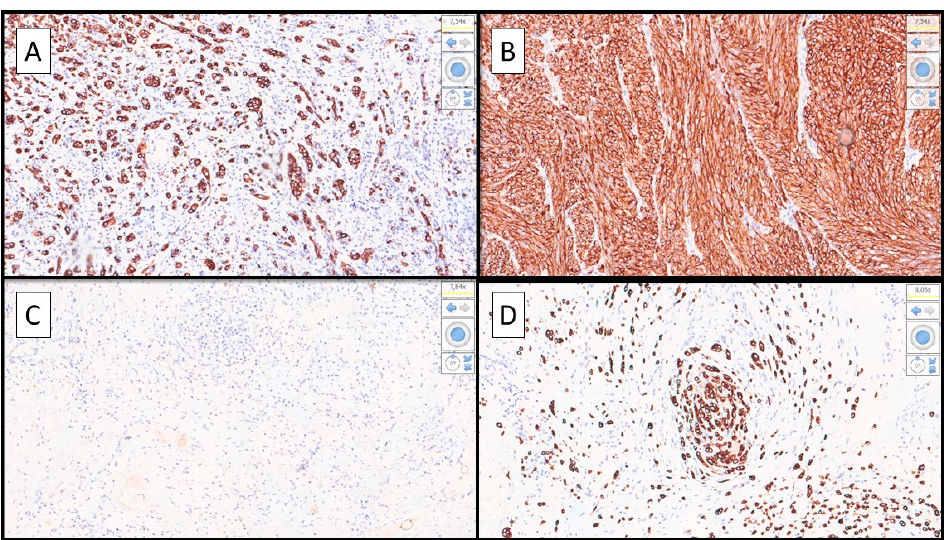
Figure 3. ( A – D ). At higher magnification, a heterogeneous morphological pattern was evident, consisting of different aspects; alongside the superficial spreading type (SSM) melanoma component (not shown) there were hyperpigmented epithelioid cell aspects ( A ), hypopigmented spitzoid features ( B ), nevoid aspects that tended to lose HMB-45 immuno-expression ( C ), and aspects of desmoplastic / neurotropic melanoma ( D ). Furthermore, a rhabdoid appearance could be appreciated (not shown). Note in ( D ) neurotropism of malignant melanoma cells (red arrows). (Hematoxylin-Eosin, Original Magnification 20×). Indeed, it has been decided to have the patient undergo sentinel lymph node surgery (BLS) and then, based on the result, a decision will be made for possible medical therapy. It is very important to recognize the different morphological forms of MM, as it is recognized in the literature to what varying extents this neoplasm is able to be “plastic”. For example, in a recent paper, Massi D. et al. dealt with the discourse relative to the morphophenotypic and genetic plasticity of MM, analyzing the very rare case of dedifferentiated MM [1].